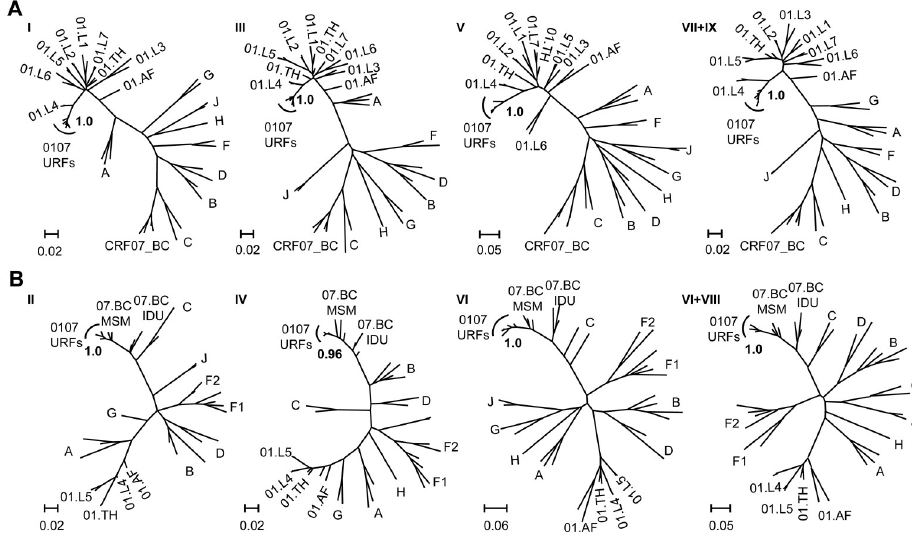
Fig 2. Sub-region phylogenetic analysis of NFLG of six 0107 URFs. Six HIV-1 CRF01_AE/CRF07_BC recombinants were divided into nine segments (I-IX) according to the recombinant breakpoints shown in the HIV-1 structure diagram in Fig 1B. ML trees were constructed by Fast tree and edited by Fig tree v1.4.2, poster probability values over 0.90 were shown at each node. (A) The subtypes of segment I, III, V, VII, IX were CRF01_AE. (B) The subtypes of segment II, IV, VI, VIII were CRF07_BC. The segment VIII and IX were too short in some patients and were combined the segment VI and VII, respectively to construct ML trees. The scale bars were shown at the bottom of each sub-region tree. ML tree, Maximum likelihood phylogenetic